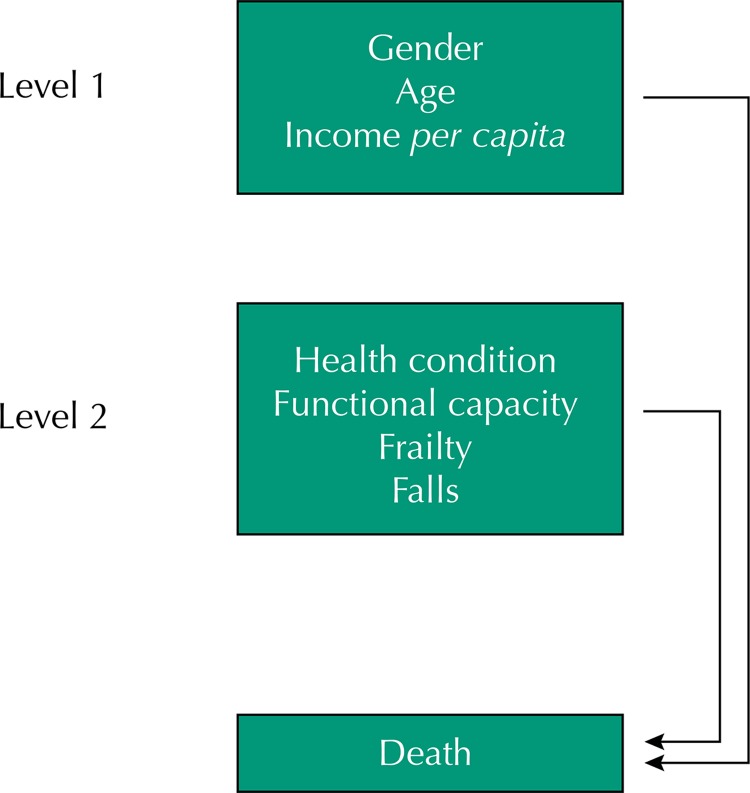
Theoretical model for the investigation of risk factors for mortality in the elderly, structured into hierarchical levels.